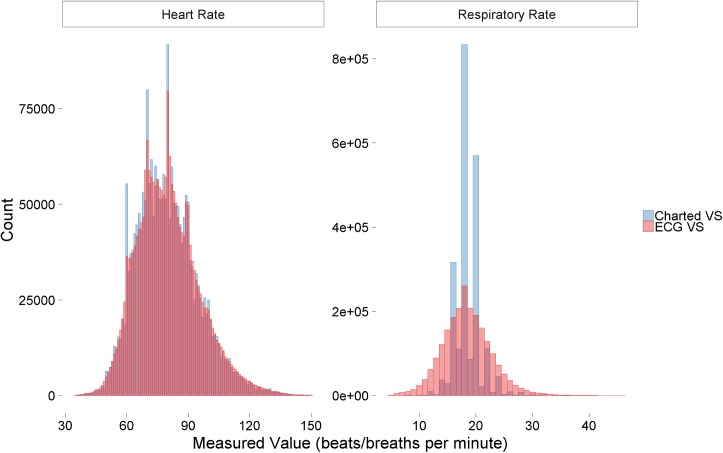
Distributions of measured heart rate and respiratory rate.Heart rate (left) and respiratory rate (right) measurement distributions according to source, charted vital signs (VS; blue) vs electrocardiography (ECG; red) where each source had equal numbers of measurements.